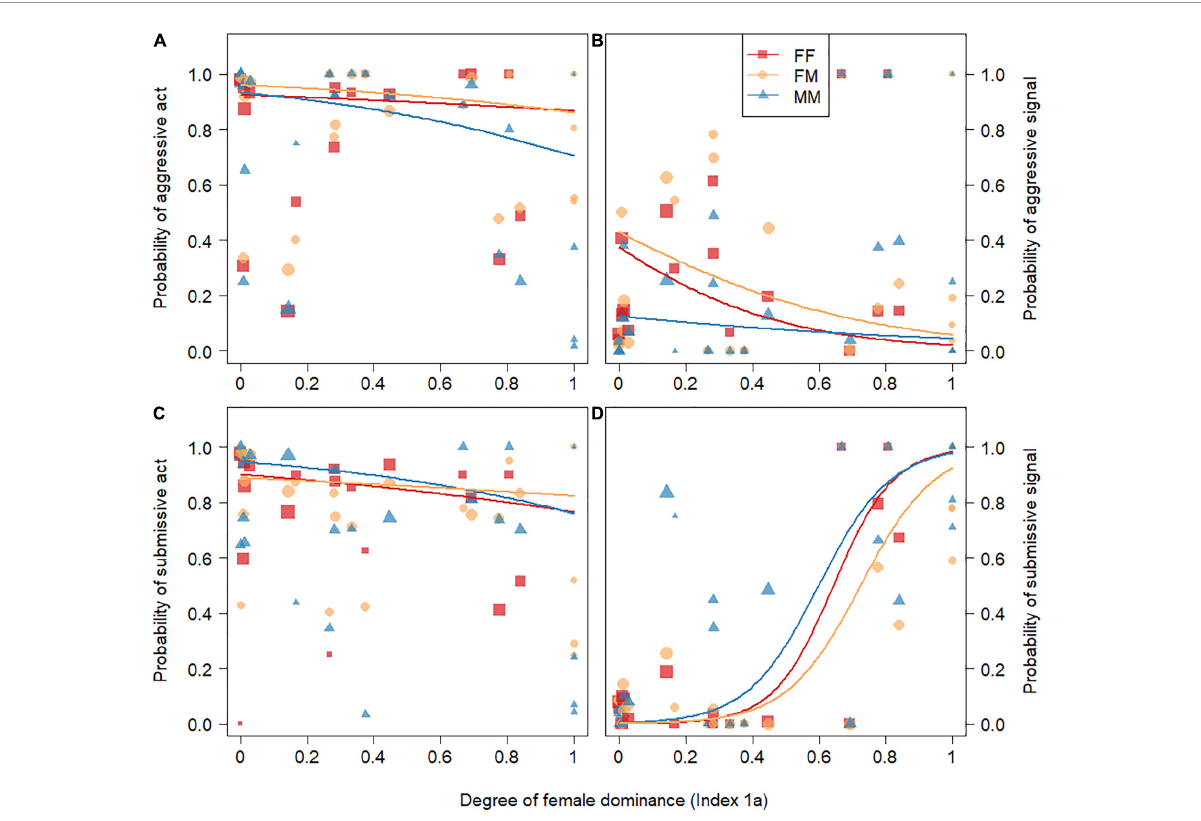
FIGURE4 Influence of the degree of female dominance (Index 1a) and dyad type (FM, FF, MM) on the likelihood for conflicts to comprise aggressive acts (A) , aggressive signals (B) , submissive acts (C) , or submissive signals (D) . Each dyad type is depicted using a different color and symbol: Red square: female-female dyads (FF), orange circle: female-male dyads (FM) and blue triangle: male-male dyads (MM). Each dot represents one dyad type of a study group on a given year and dot size is proportional to the log number of dyads. Log scale was chosen here because the number of dyads in each dyad type in the largest groups were orders of magnitude larger than in smallest groups. The red, orange and blue lines depict the predicted relationship between the degree of female dominance and the likelihood of each act or signal to occur for FF, FM, and MM dyads respectively. These lines are derived from Models 2a (panel A ), 2b (panel B ), 2c (panel C ), and 2d (panel D ). Please note that for Model 2c the full model did not significantly differ from the null model and the corresponding lines do not represent meaningful statistical relationships but are used for